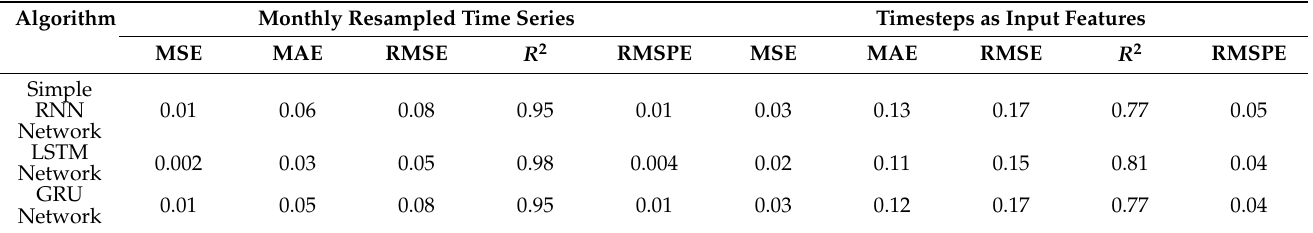
Table 12. Results when forecasting from all OCT data (including fundus image embeddings), from three previous